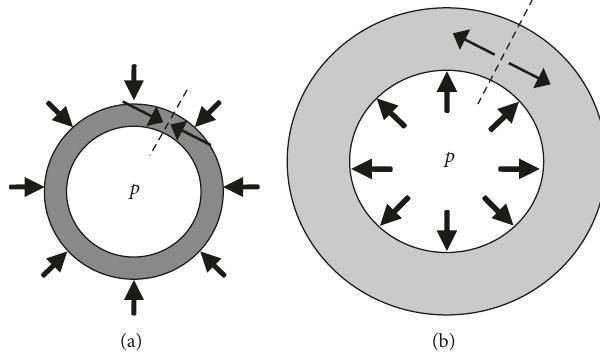
Figure 11: Stress transfer mechanism in ring test: (a) inner steel ring; (b) outer concrete ring.